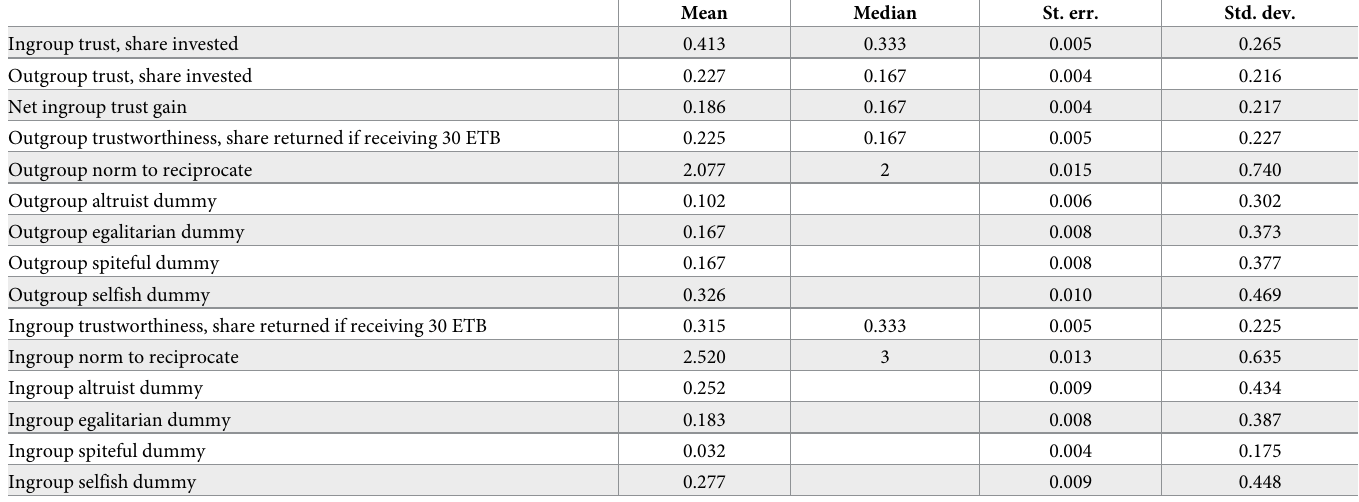
Table 3. Summary statistics for key